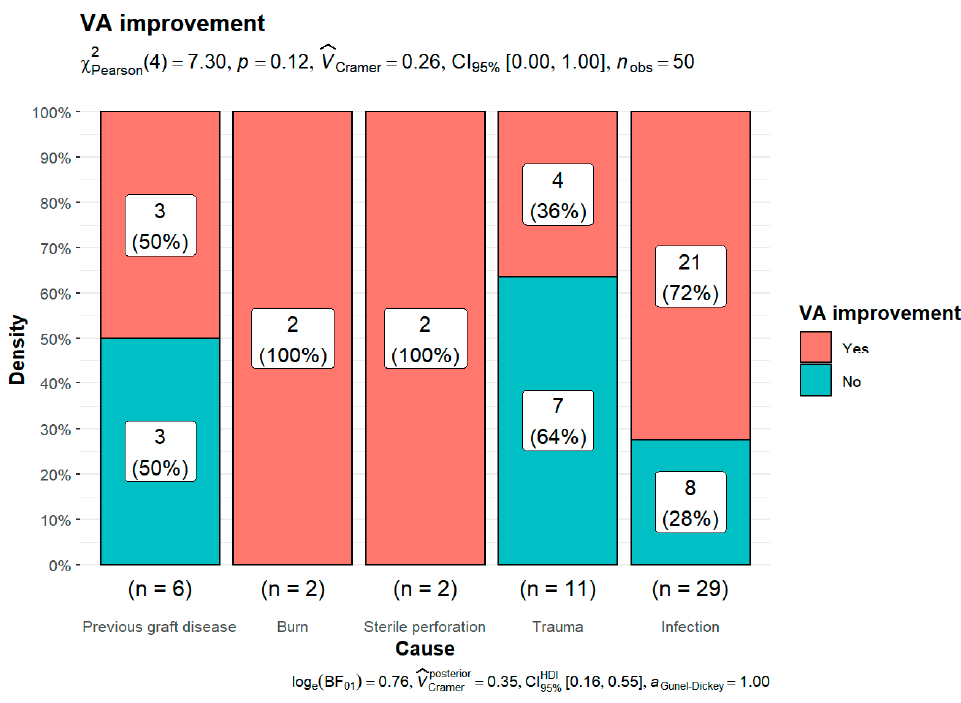
Figure 3. Relationship between VA improvement and etiology of corneal blindness.